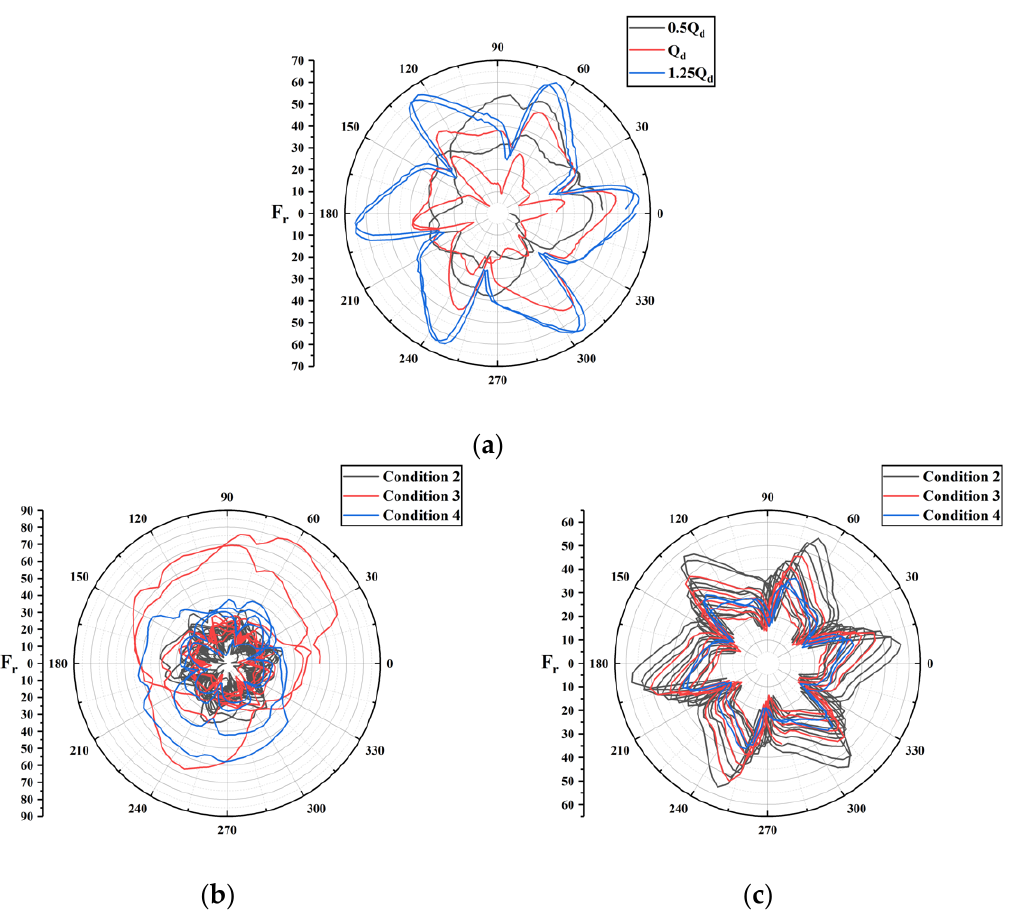
Figure 15 . Polar diagram of the blade’s radial force under constant flow rate conditions ( a ), polar diagram of the blade’s radial force under variable flow rate conditions from 0.5 Q d to Q d ( b ), and from Q d to 1.25 Q d ( c ).